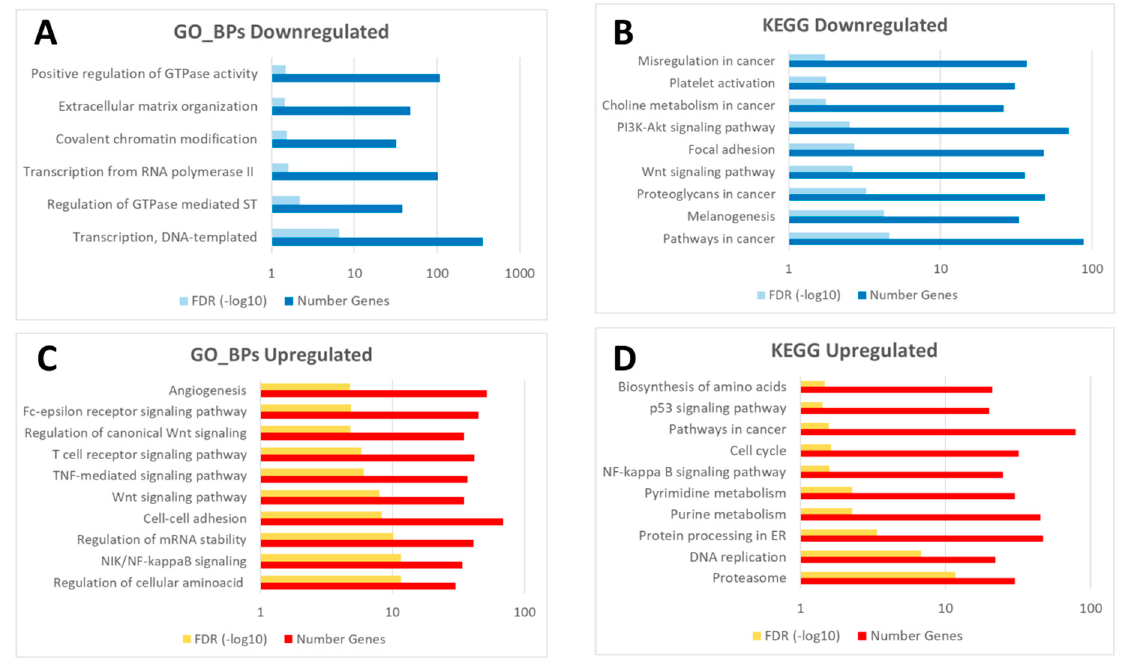
Figure 4. Diagram of common enriched functions (GO_BPs: Gene Ontology biological processes, and KEGG pathways) in the downregulated ( A , B ) and upregulated probes ( C , D ) in response to wounding in both groups (C24vsC0 and D24vsD0). The complete list of enriched GO_BPs and KEGG pathways is available in Table S4 (sheet tabs A and B).